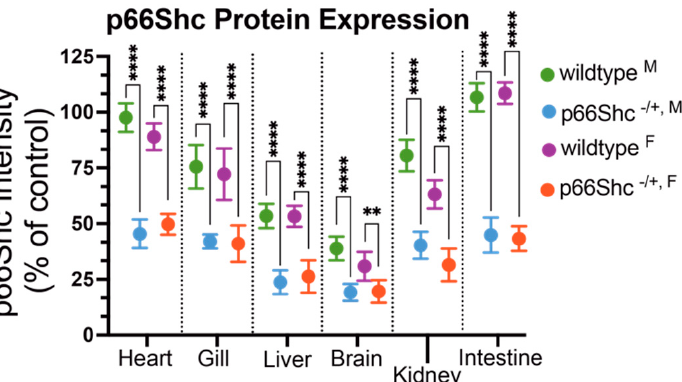
Figure 3. p66Shc protein expression in GFP +/+ (wildtype) and GFP +/+ p66Shc − /+ hypomorphic allele zebrafish. Heart, gill, liver, brain, kidney, and intestines were harvested from male (M) and female (F) zebrafish. Parental genotypes indicated in color (green and blue for male, purple and orange for female). **** = p -value < 0.0001, ** = p -value < 0.01, N = 7 independent fish for each measurement and presented as mean ± SD.